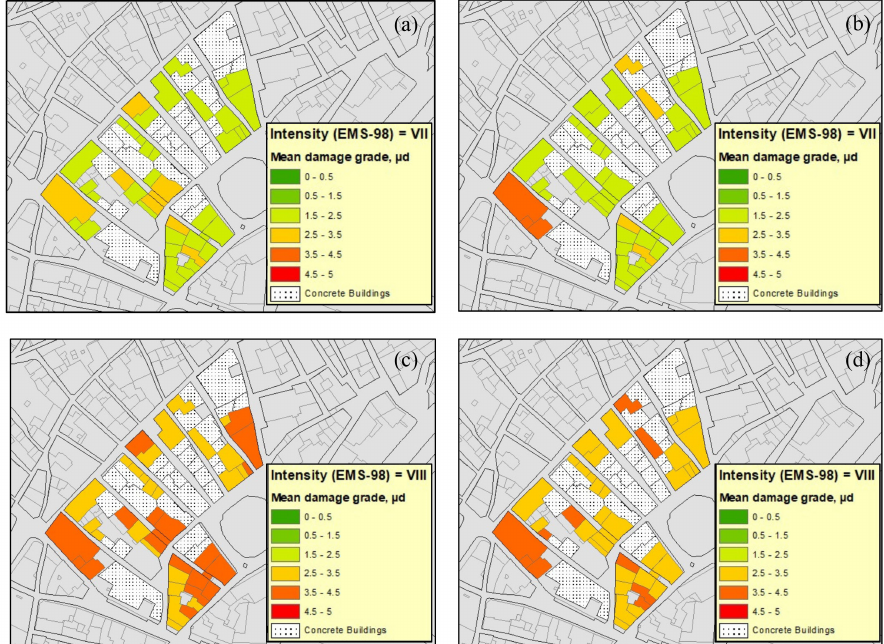
Figure 19. Damage scenario for different macroseismic intensities I EMS-98 , considering central values ( a , c ) and reference values ( b , d ) of Vulnerability Index I v , based on the façade